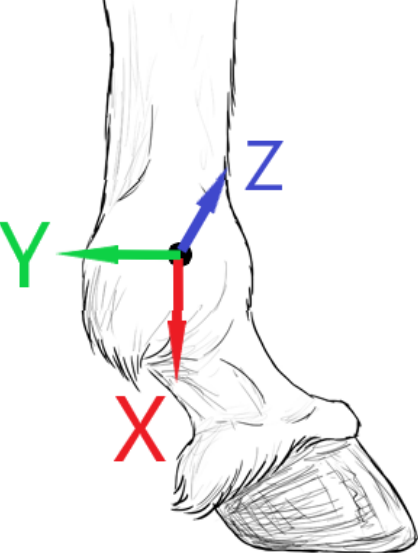
Figure 1. The accelerometer logging sensors are attached at the lateral side of both front legs. The x-direction is pointing downwards, the y-direction backwards and the z-direction sidewards of the